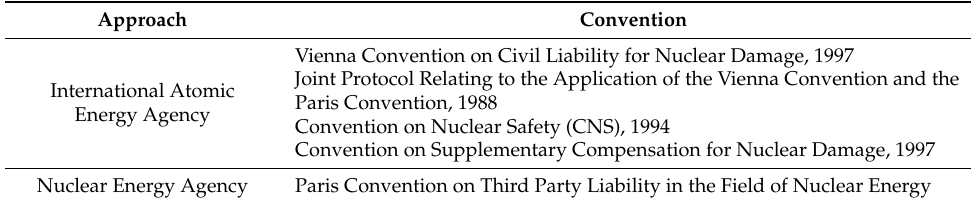
Table 1. Overview of nuclear liability